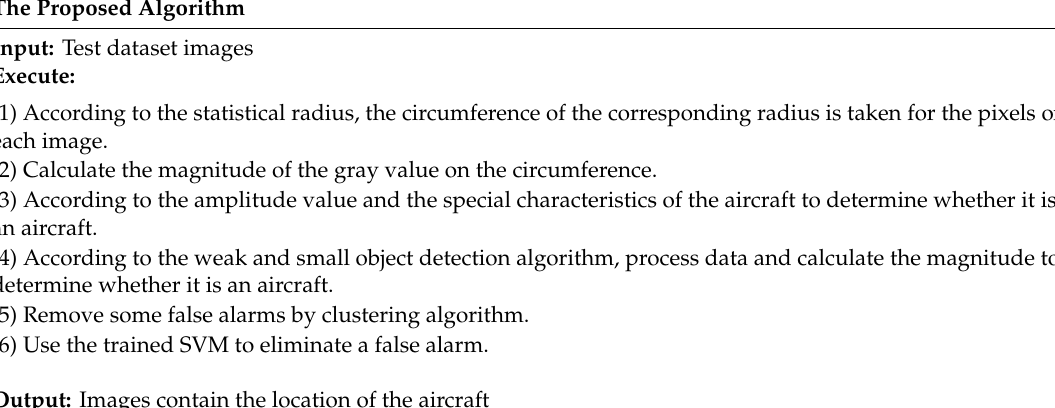
Table 1. The fusion algorithm